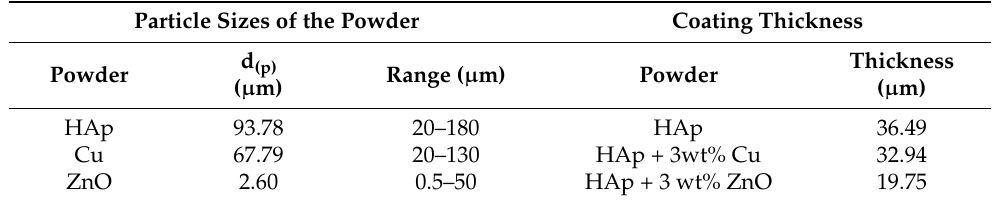
Table 1. On the left: Particle sizes of the powder hydroxyapatite (HAp), copper (Cu), and zinc oxide (ZnO) used. The median particle size (d (p) ) and range are listed in µ m. On the right: The coating thicknesses of the surfaces after the coating procedure are shown in µ